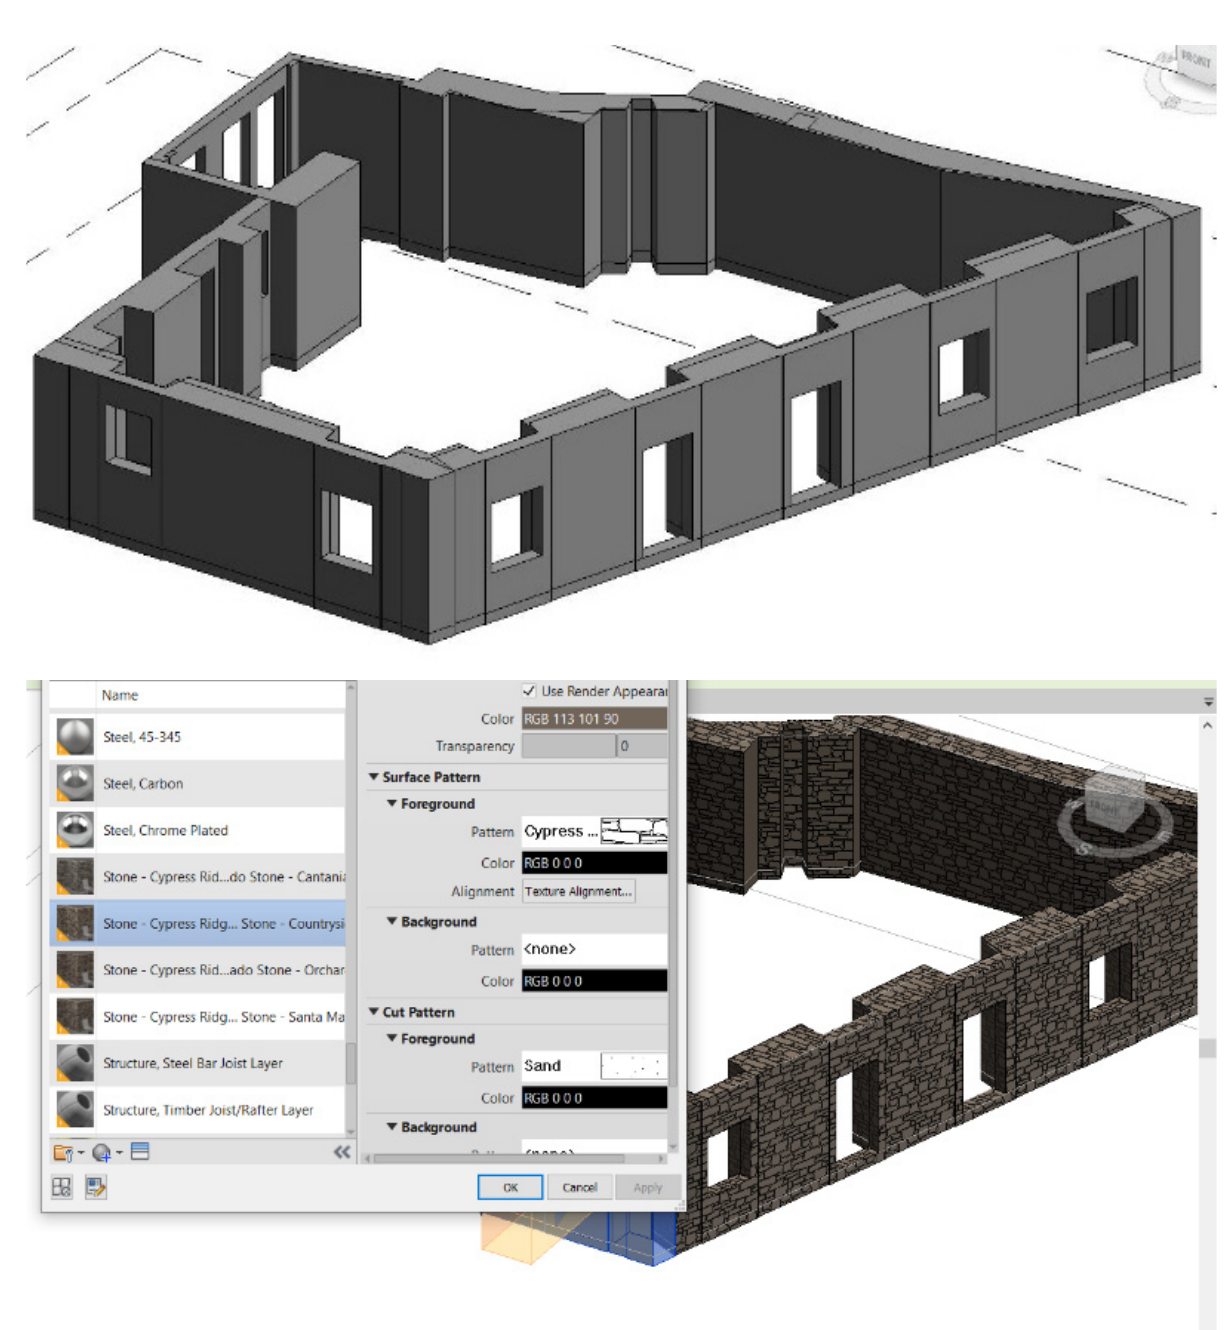
Figure 4. 3D representation of the walls in floor 0 and selection of the material (stone-cypress).